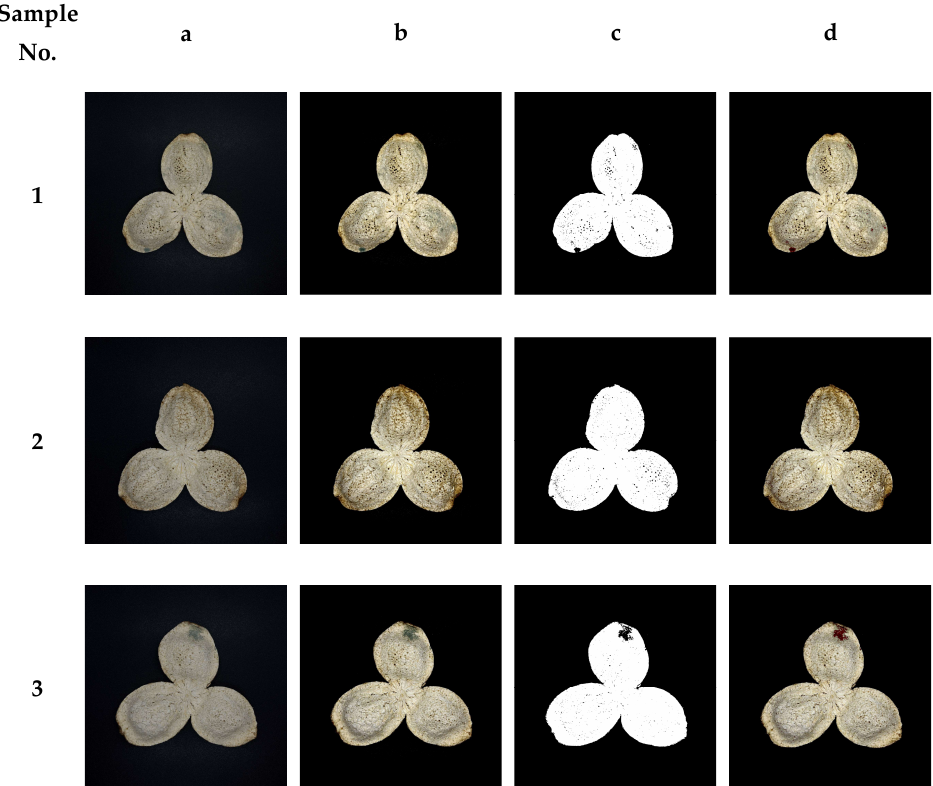
Figure 12. Image characterization of PCRC samples 1, 2, and 3. ( a ) Original image; ( b ) Image after denoising and contrast optimization; ( c ) Image segmented by EXR and Otus methods; and ( d ) The stacking image.